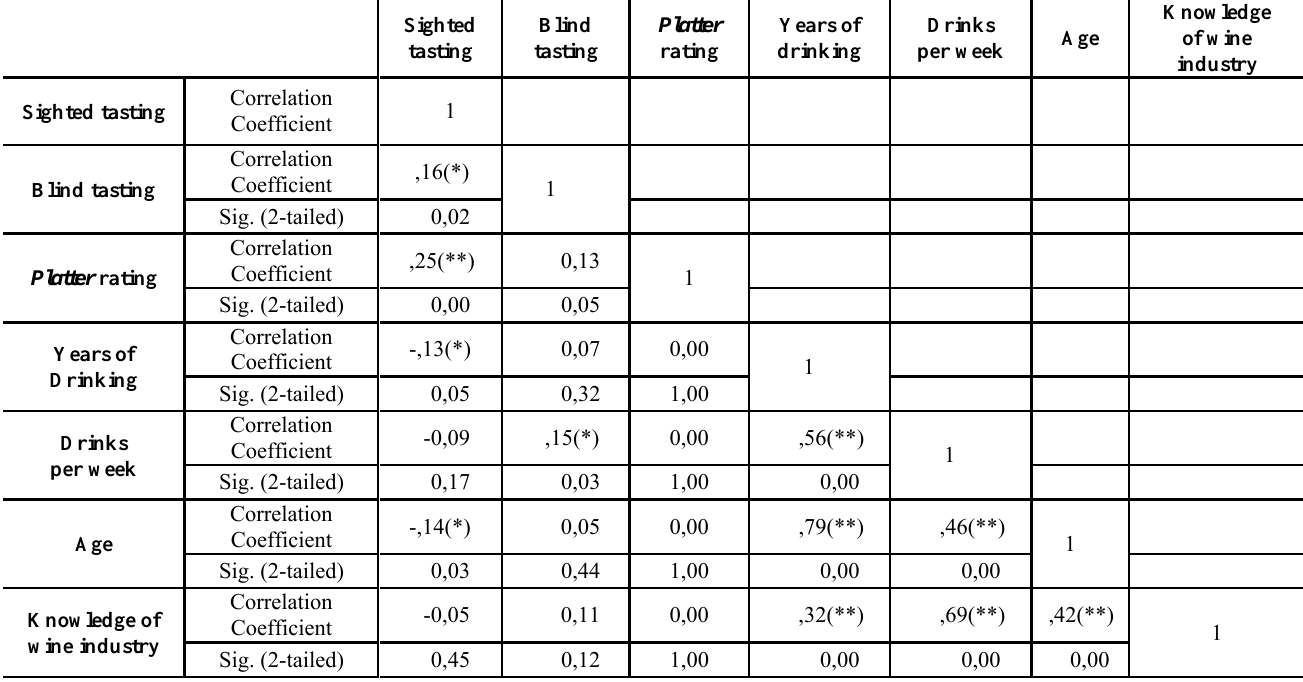
Table 3: A Spearman’s rank correlation matrix depicting variables across the entire dataset